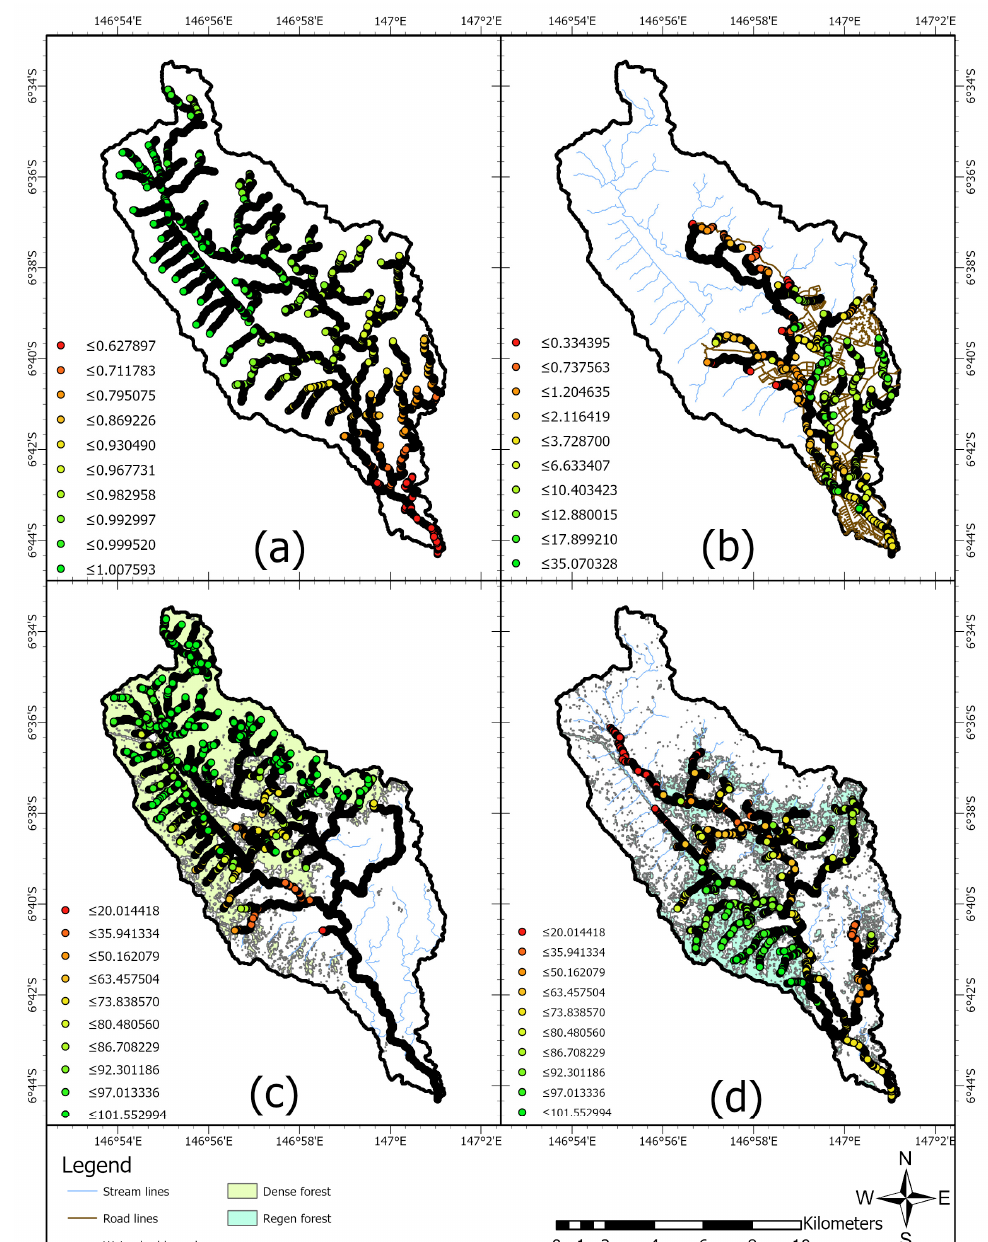
Figure 11. Distribution of ( a ) normalized rainfall pattern, ( b ) ROAD RUNOFF importance values (IV) scaled 1 to 200 overlain on roads/streets layer, ( c ) DENSE FOREST RUNOFF importance values (IV) scaled 1 to 200 overlain on dense forest polygons and ( d ) REGEN FOREST RUNOFF importance values (IV) scaled 1 to 200 overlain on regen forest polygons.